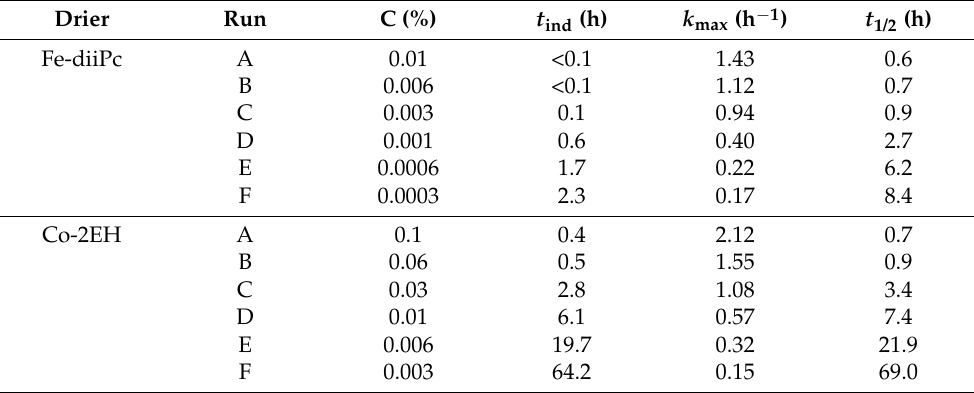
Table 5. Kinetic parameters for formulations of the binder S471 1 .